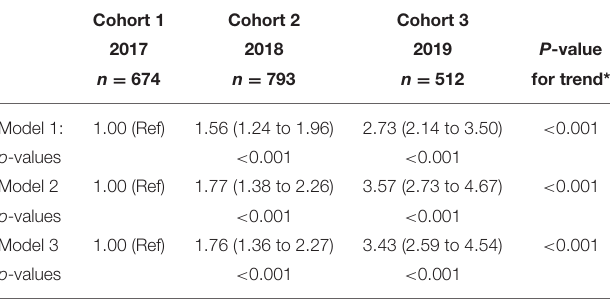
Association between year cohort with TT/DT antithrombotic treatment. Model 1 was crude model, with no adjustment. Model 2 was adjusted for AF type, CAD type and treatment type. Model 3 was further adjusted for factors in CHA2DS2- VASc score, namely, age, sex, CHF, hypertension, diabetes mellitus, stroke/TIA/SE, prior- myocardial infarction, and peripheral arterial disease. * p-value for trend was calculated using logistic regression